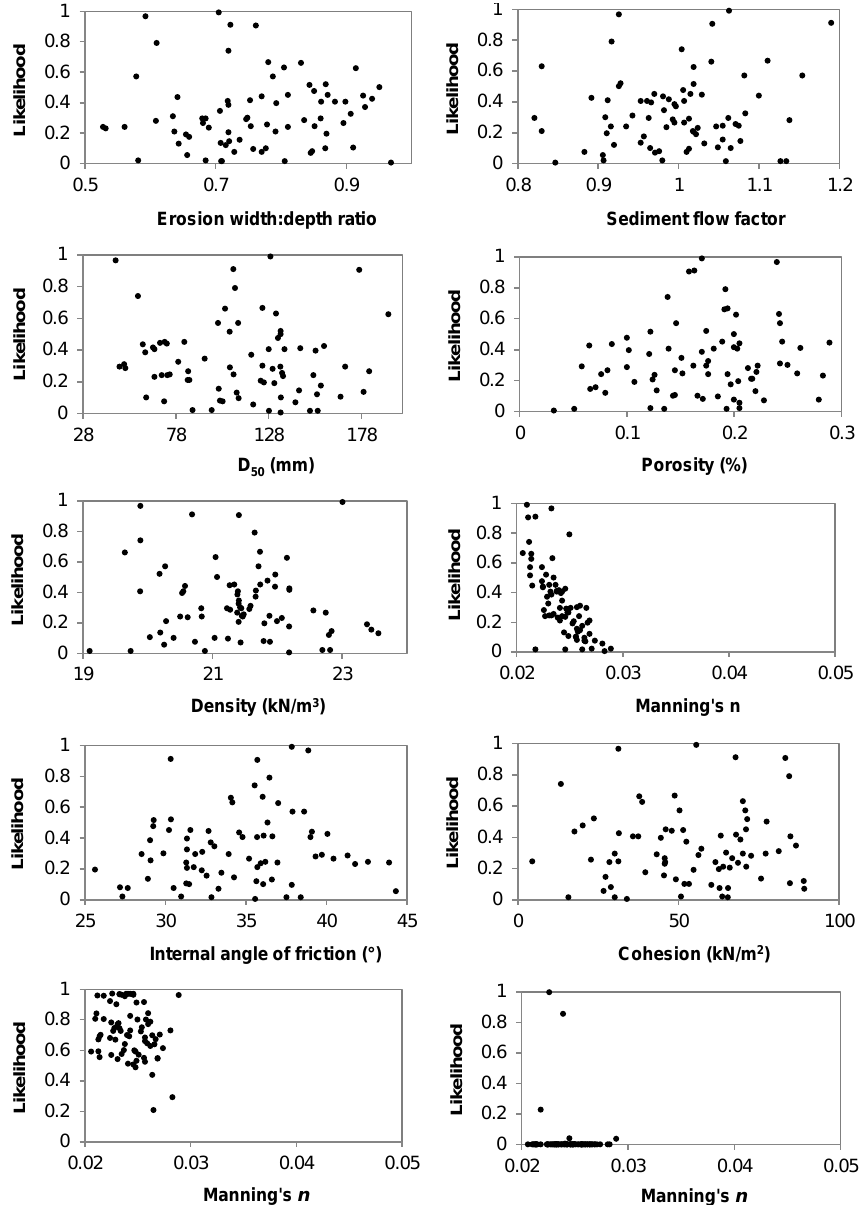
Figure 7. Scatter, or “dotty”, plots of likelihood values for HR BREACH input parameters for behavioural Monte Carlo simulations of DT_control, conditioned on final breach depth. The bottom two panels represent the Manning’s n likelihood surface for results conditioned on final breach depth and residual slope error (bottom left panel); and final breach depth, residual thalweg elevation error, and final flow constriction location (bottom right